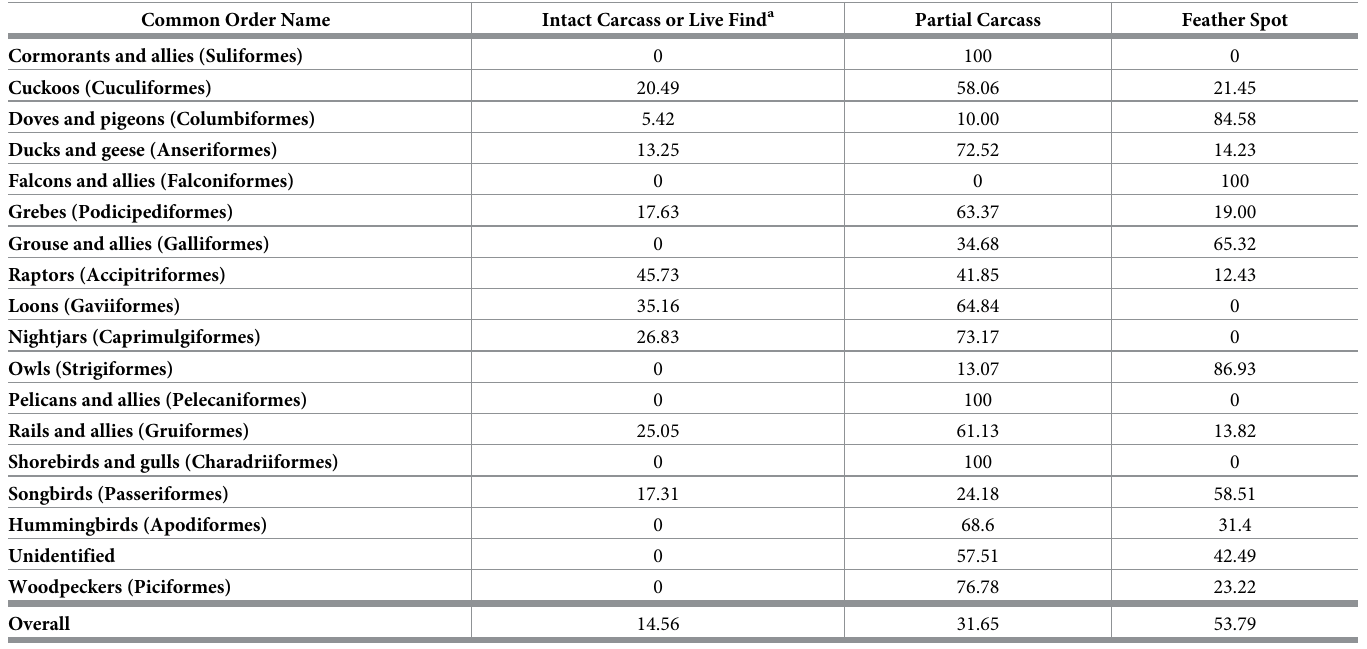
Table 2. Adjusted composition by taxonomic order and carcass condition for detections provided in fatality monitoring reports ranging from January 1, 2013, to September 1,